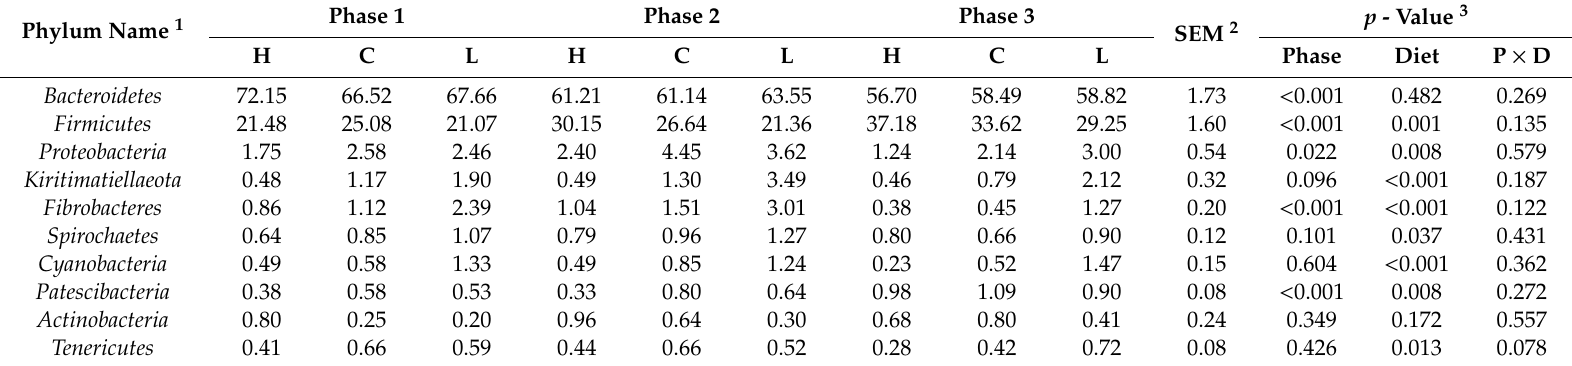
Table 6. E ff ects of dietary nutrient density on rumen bacterial composition at phylum level (relative abundance > 0.5%) in the whole fattening phases of Holstein